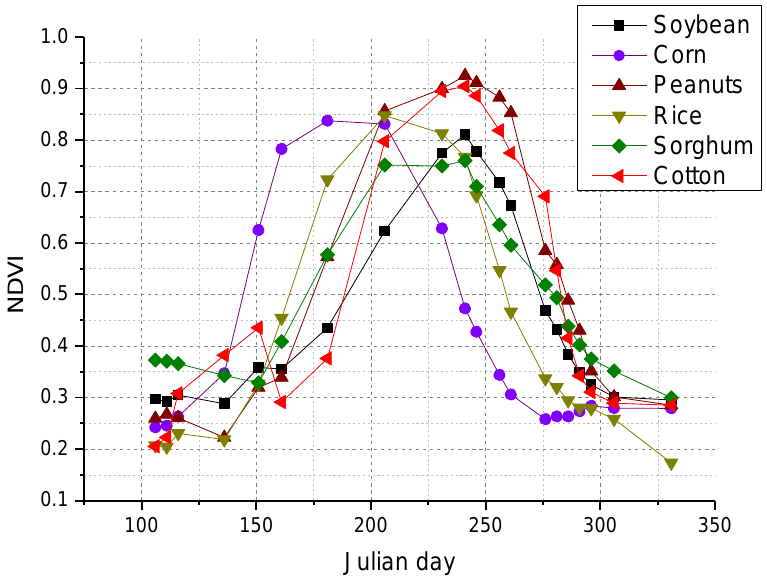
Figure 4. Normalized difference vegetation index (NDVI) time series of various crops in MO-08.